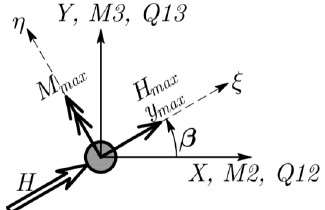
Figure 6. Directions of the maximum displacements y max , shear forces H max , and bending moments M max . Loading direction is governed by the loading direction angle β . X, Y, Q12, Q13, M2, and M3 denotes the directions of displacements, shear forces, and bending moments in XY space in PLAXIS 3D, respectively.